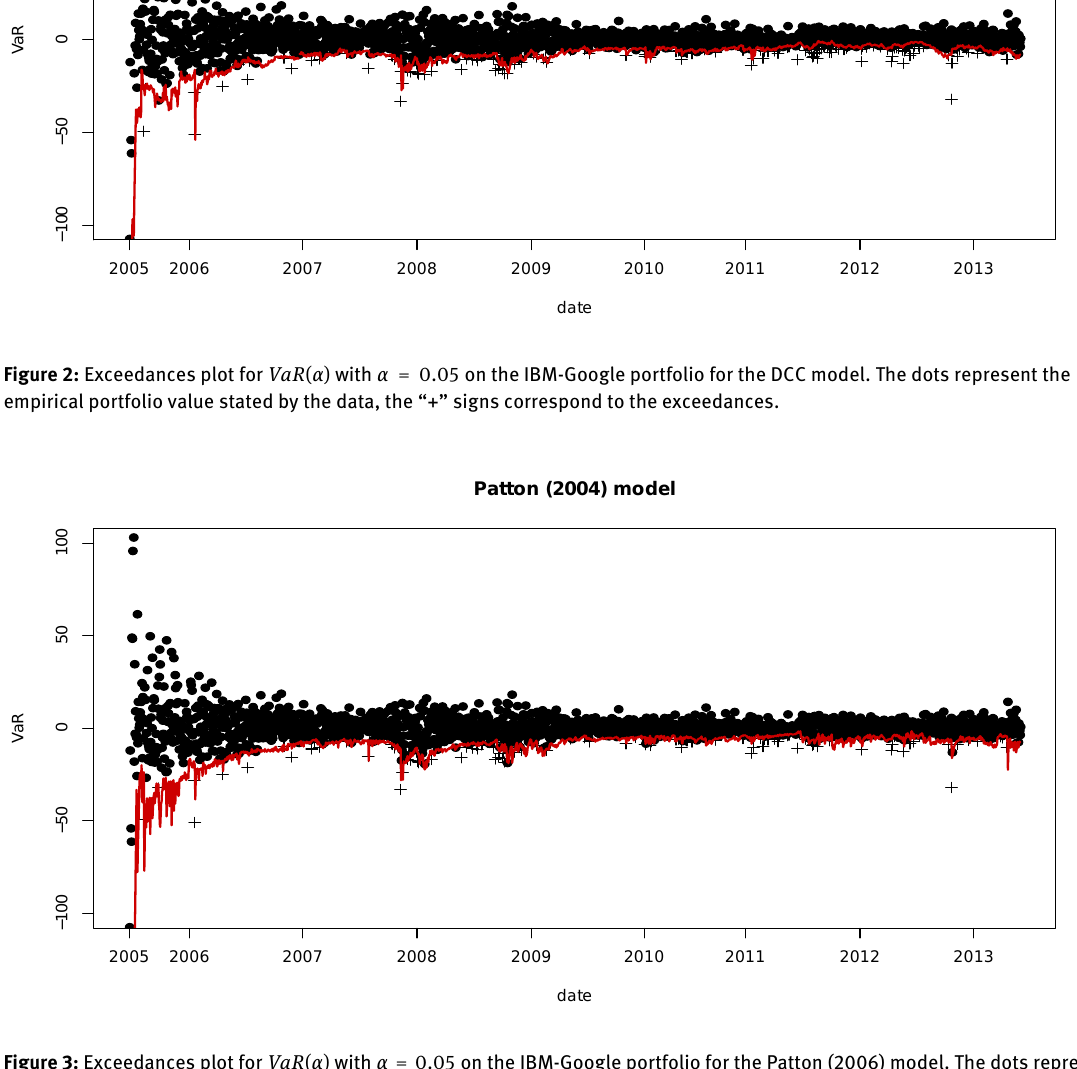
which shows a statistically insignificant estimate for ˆ α . The proposed Lévy model does not show exceptional results, but behaves ordinarily for levels α = 0.05 and α = 0.1 and equally badly as others for the case α = 0.01. As for the results for the ExeCoin-SocialXBot portfolio depicted in the lower panel of Table 2, the proposed Lévy copula model behaves best for the α = 0.1 but is not robust for the case of α = 0.05. It is important to notice that the Lévy copula model uses only observations from the previous day, whilst the other models need much more